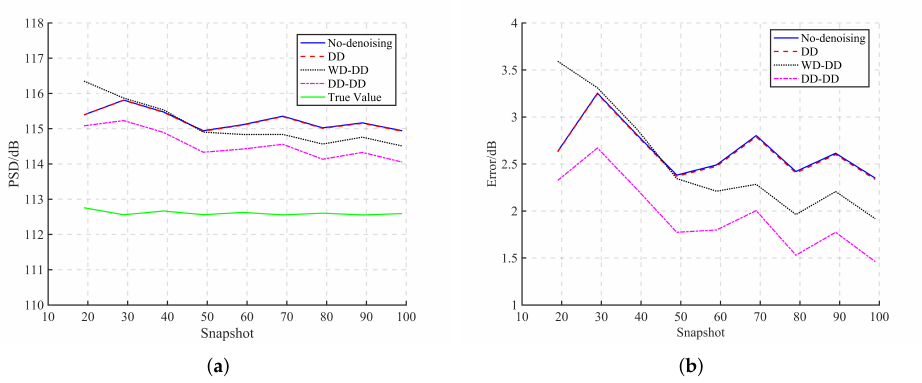
Figure 11. ( a ) The PSDs and ( b ) estimation errors of the CW signal with different numbers of snapshots.